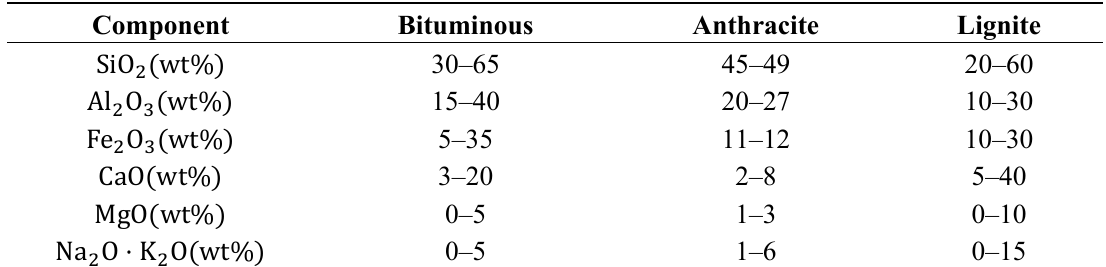
Table 1. The chemical component of fly ash.